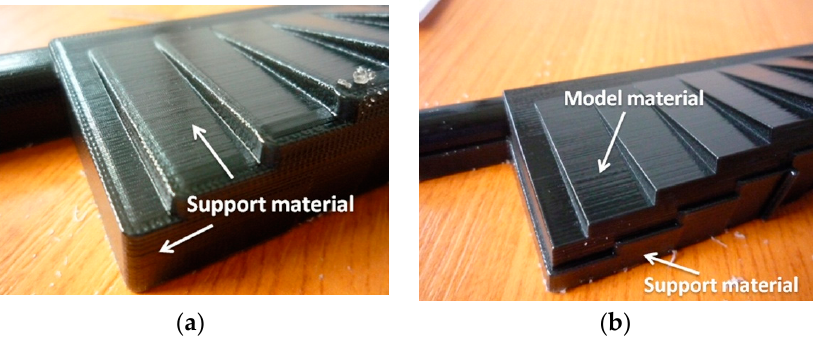
Figure 6. Finish type within PolyJet technology: ( a ) matte finish; ( b ) glossy finish. Table 2. Control factors and their level.